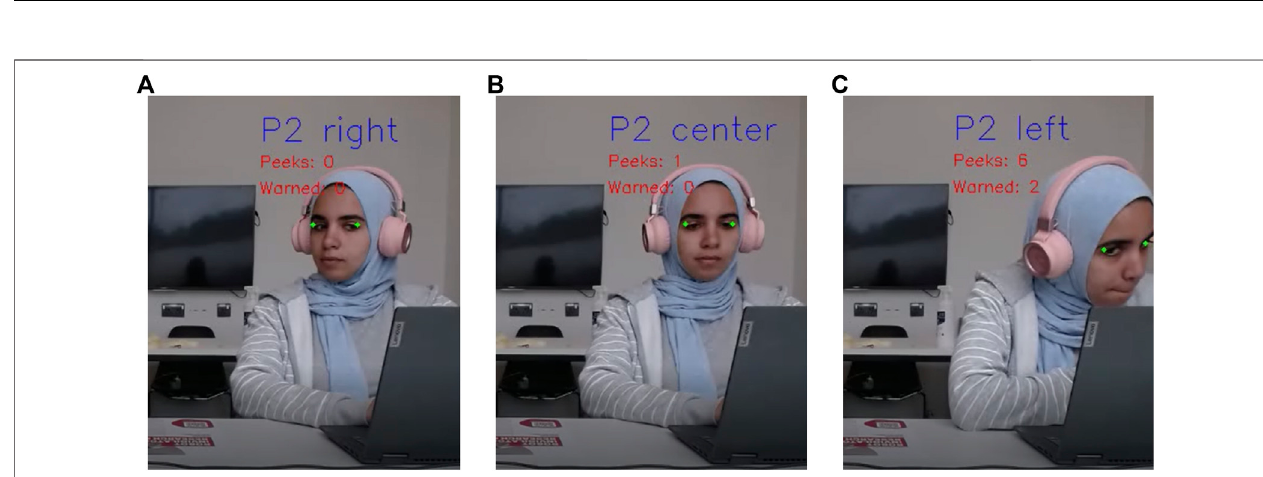
FIGURE2| Headposedirections:directions (A – C) arefromthepointofviewofthepersoninthephoto.Thecounters “ peeks ” and “ warned ” appearintherecorded video for analysis purposes.